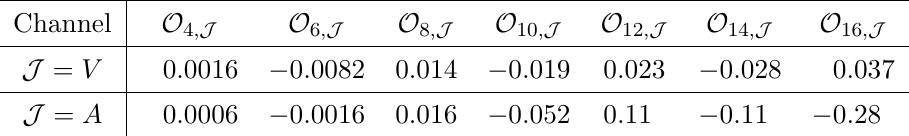
Table 5 . Fitted values of the OPE condensates (in GeV units), with FOPT and ˆ s 0 = 1 . 55 GeV 2 , using the default ansatz in eq.